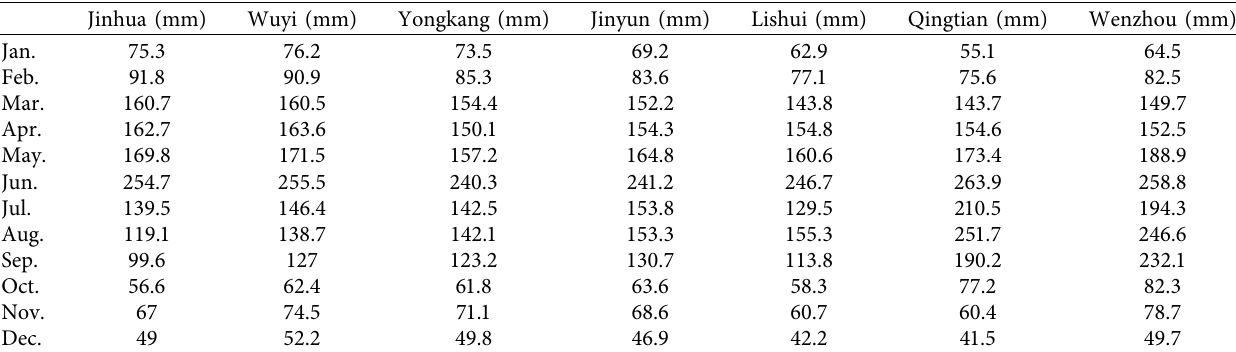
Table 5: Monthly distribution of maximum rainfall of Wenli freeway.